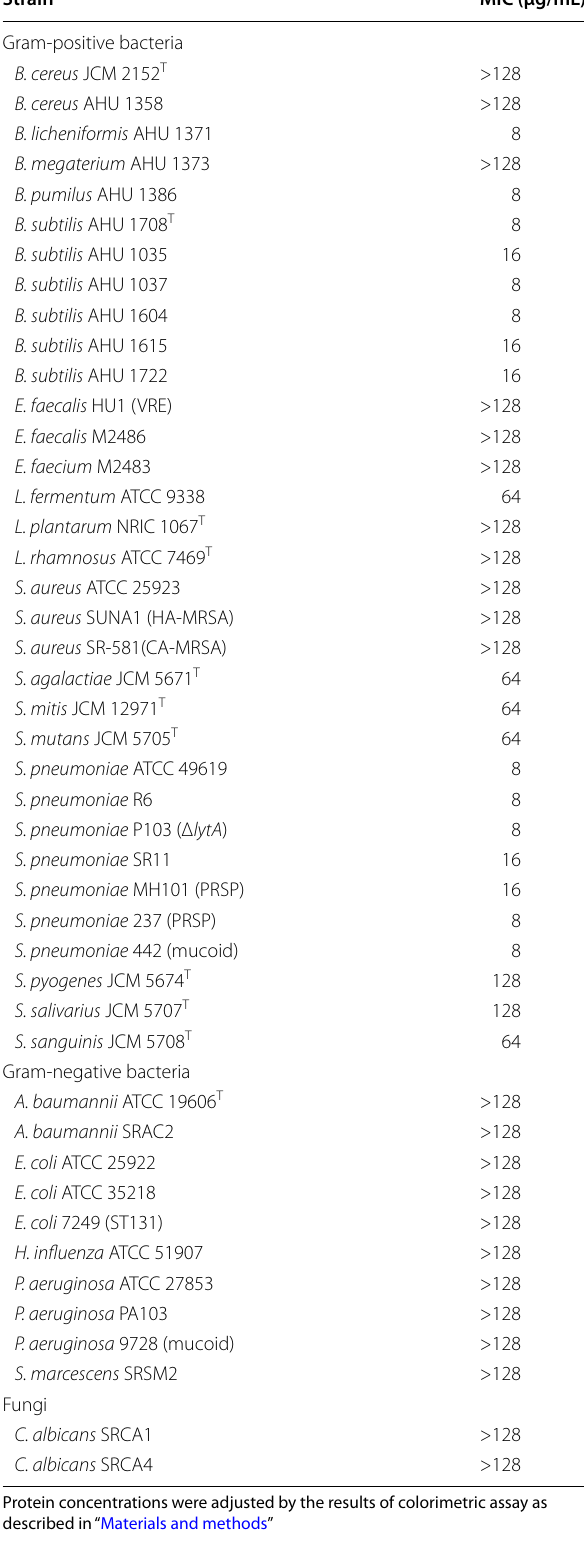
Table 2 Antimicrobial activity of the Natto peptide from various Natto preparations obtained using different soybeans and B. subtilis strains